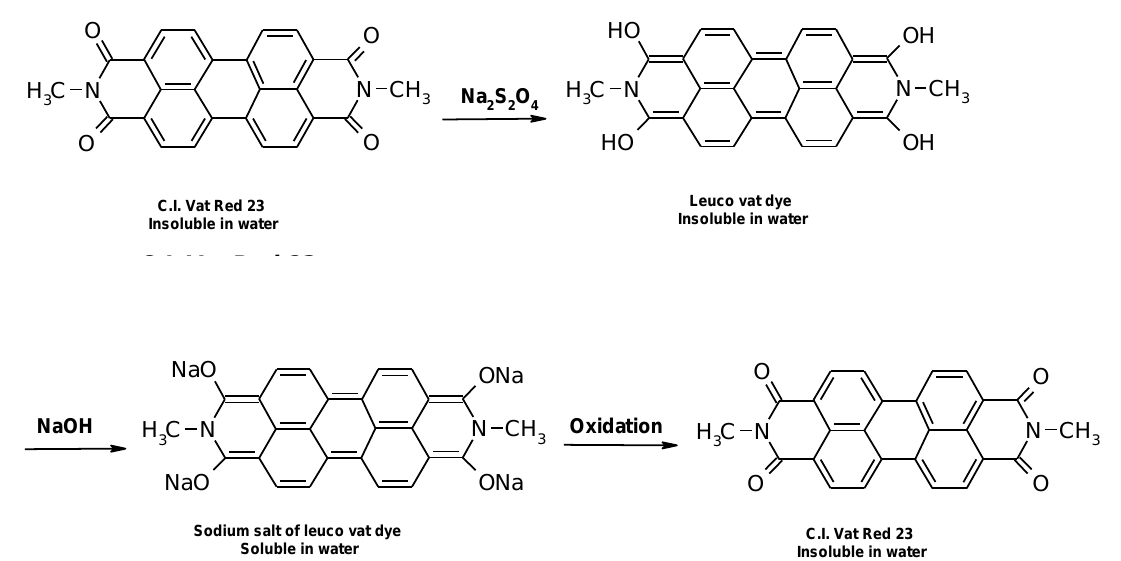
Figure 1. Schematic representation of the reduction and oxidation reaction of vat dye.